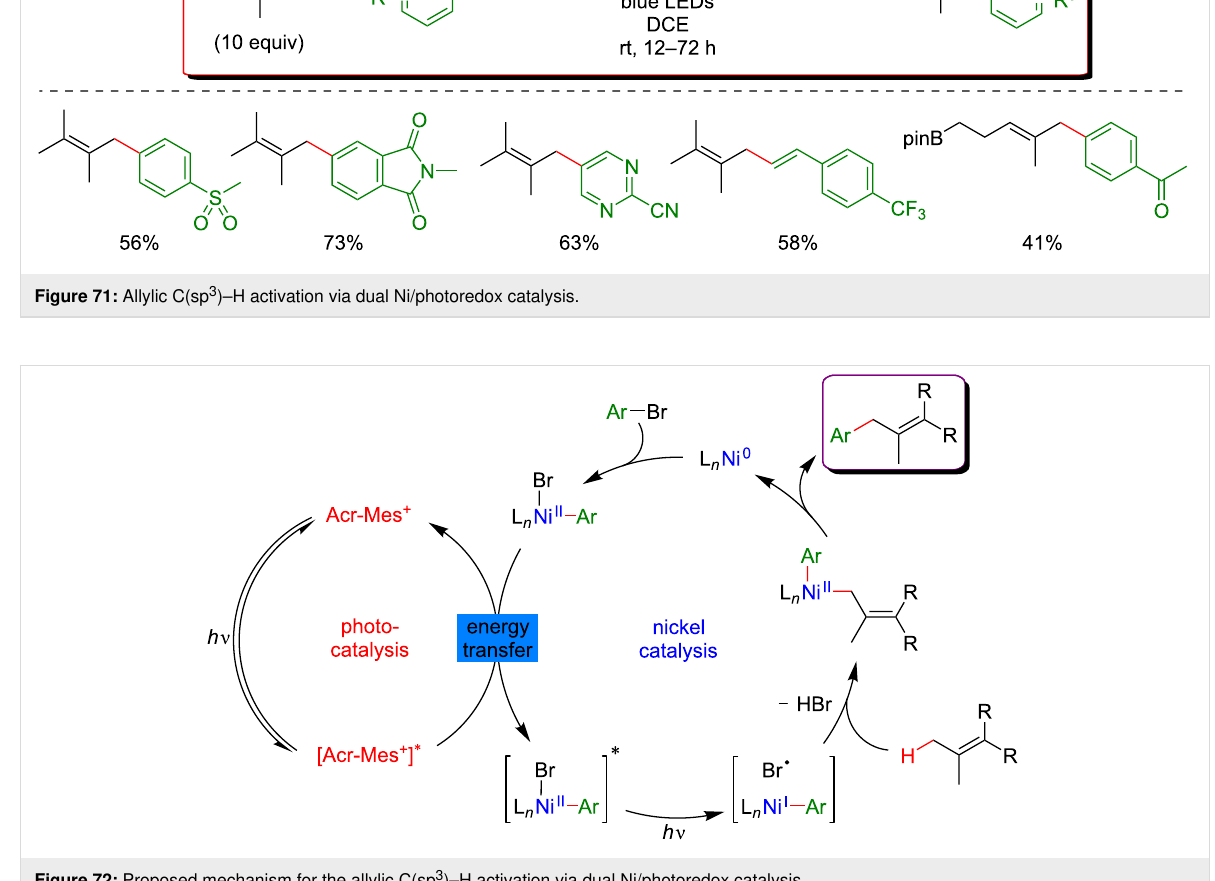
Figure 72: Proposed mechanism for the allylic C(sp 3 )–H activation via dual Ni/photoredox catalysis.